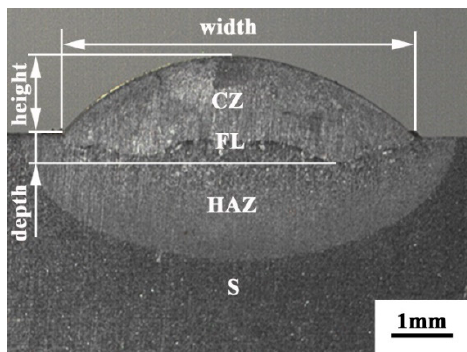
Figure 4. Macro-appearance of the cross section. Table 3. Size of all nine groups of samples.